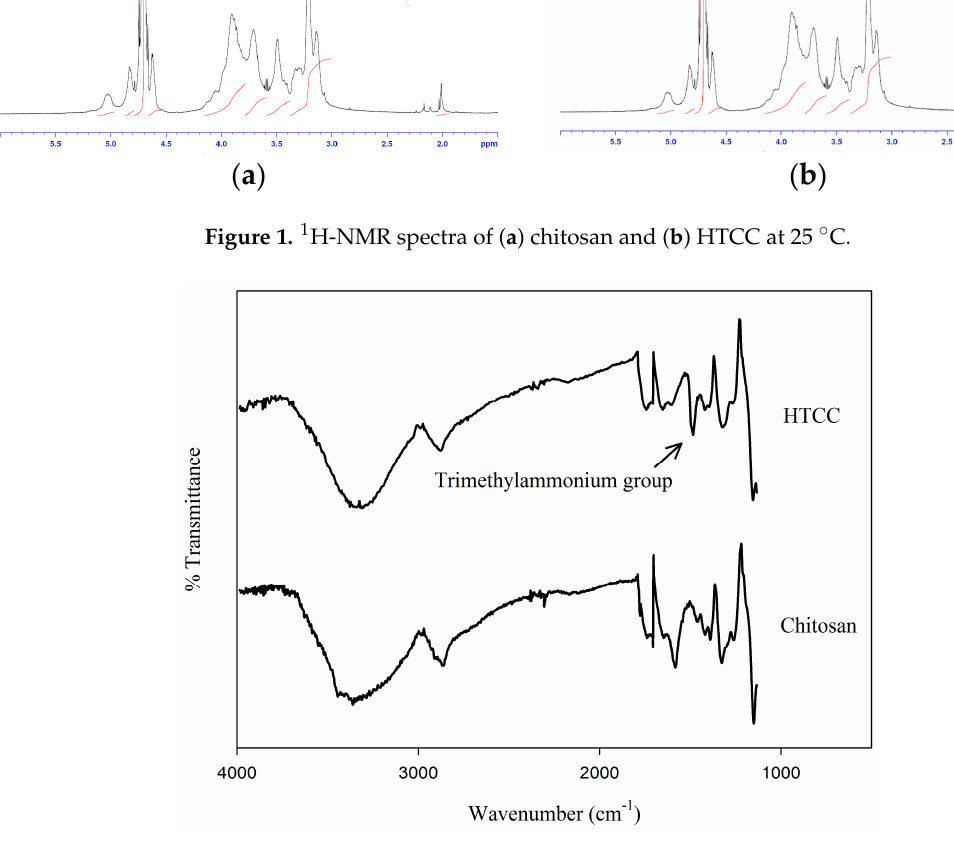
Figure 2. FT-IR spectra of chitosan and HTCC.